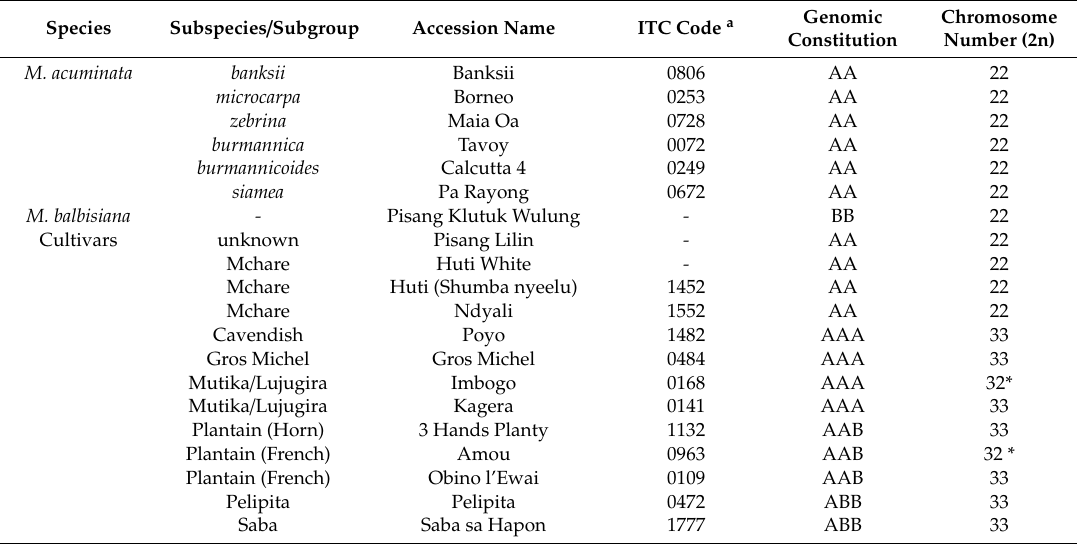
Table 1. List of Musa accessions analyzed in this work and their genomic